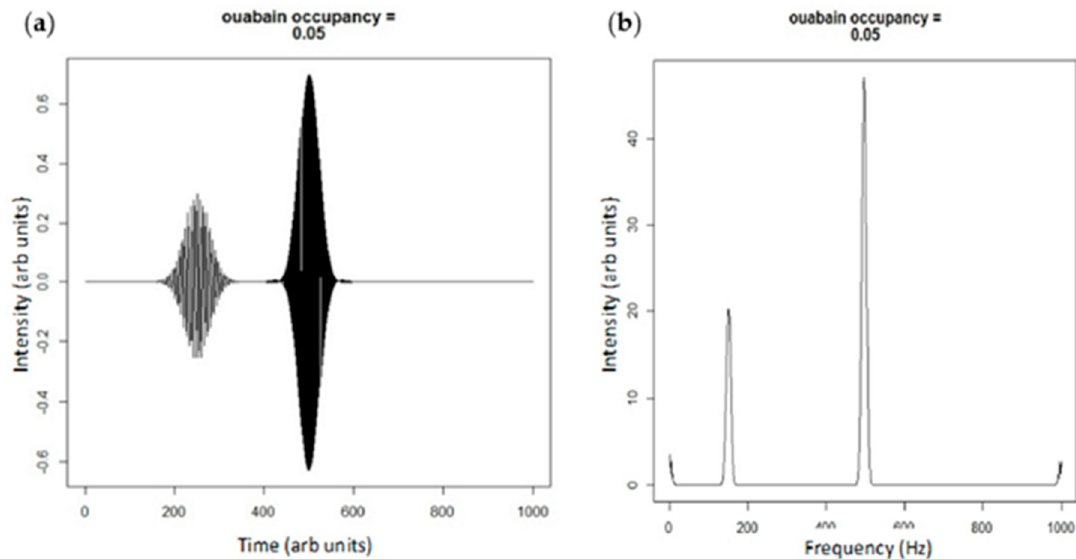
Figure 4. ( a ) Plane wave simulation of ouabain binding shifting the E2:E1 state by 5%; and ( b ) the Fourier transform of the adjacent simulation. Note that the height of the smaller peak centered at 180 Hz is diminished compared to Figure 3b representing net Src activation.